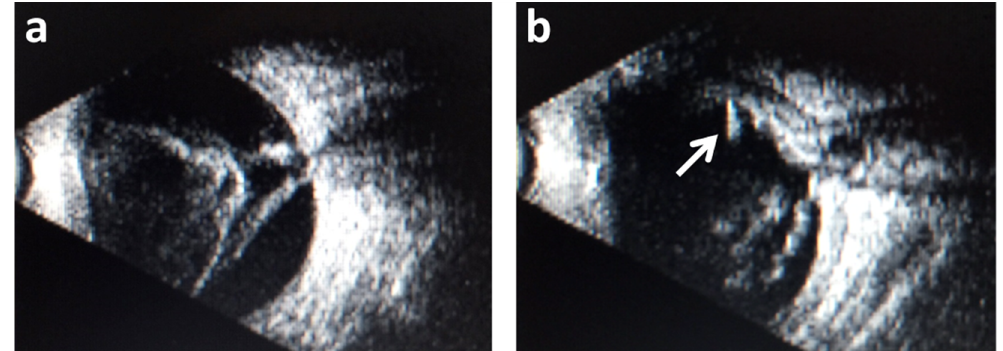
Figure 1. Findings of the B-scan ultrasonic examination. ( a ) Retinal detachment and ( b ) an intraocular foreign body (white arrow). Posterior segment abnormalities were most commonly associated with posterior uveitis, followed by undetermined and posttraumatic cataracts. Other causes had relatively low incidences of posterior segment lesions, respectively (Table 2).